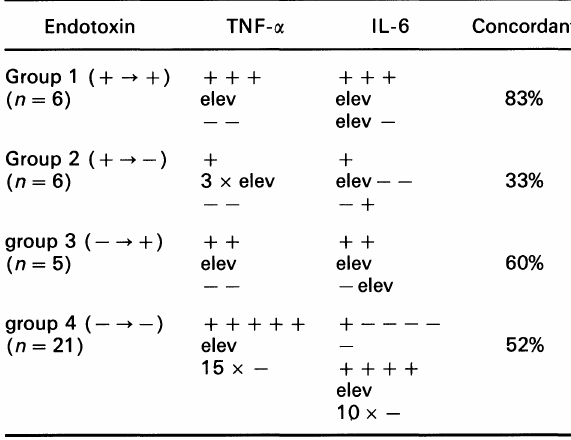
The courses of TNF- and L-6 are symbolized for each patient in corresponding order; recipients with TNF- > 100 pg/ml and with L-6 > 800 pg/ml at the end of operation (time point F) were classified as positive; elevated denotes the patients with permanent intraoperative elevations and the degree of parallel changes in the cytokines under investigation for individual patients is shown as percentage of